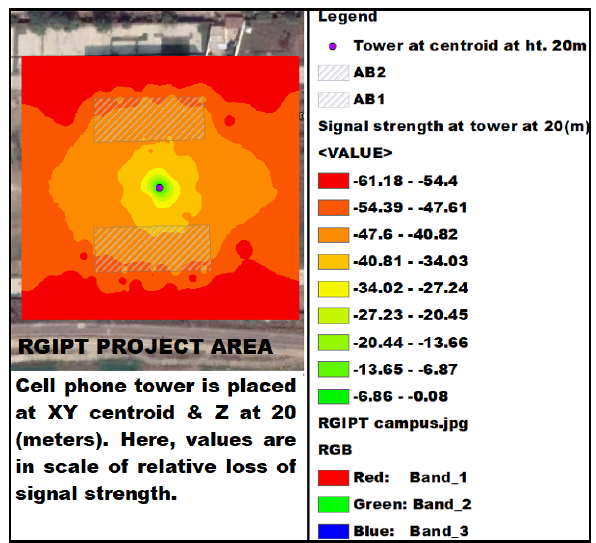
Figure 16. Cell phone tower at XY Centroid and Z at 6 meters